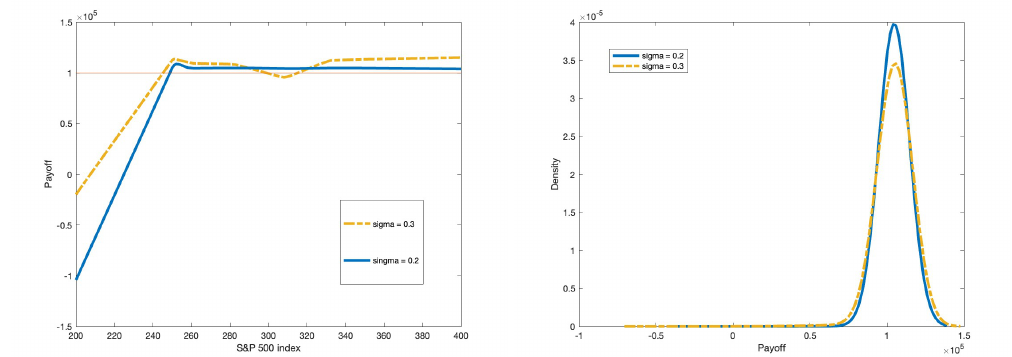
Figure 4. The payoffs of the optimized portfolios as functions of the index value at the expiry date obtained with σ = 0.2 and σ = 0.3 ( left ), and the kernel density of the payoff of at the optimized portfolios obtained with 10,000 out-of-sample simulations ( right